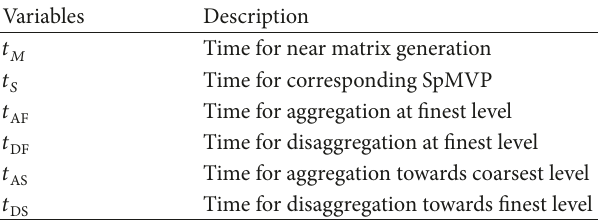
Table 3: Variables definition of time